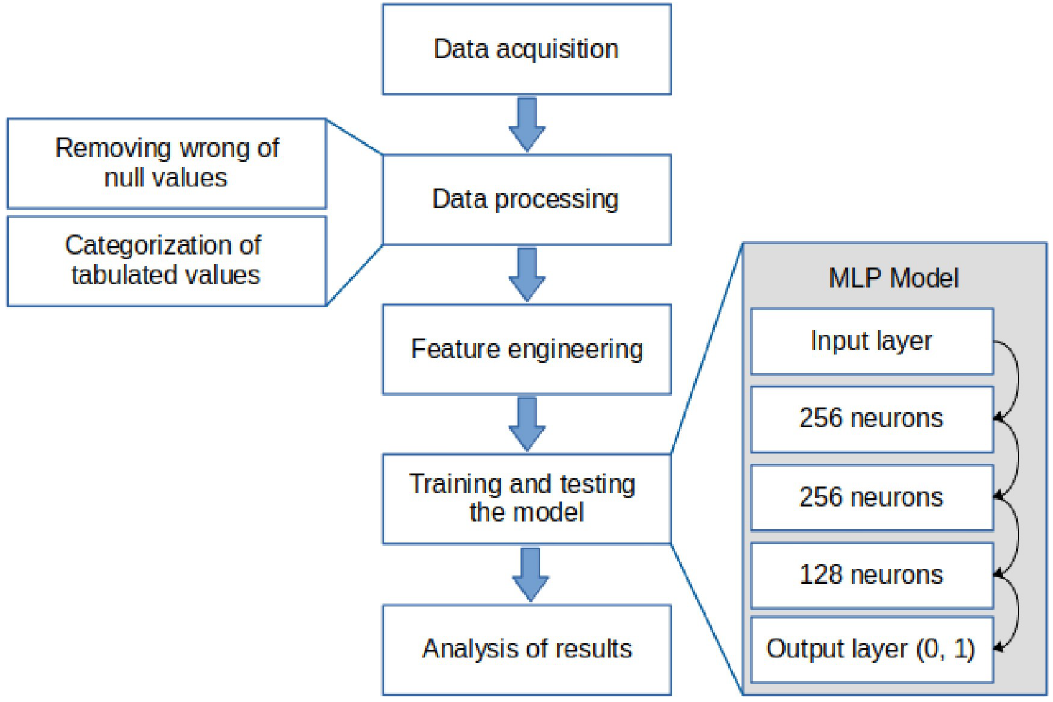
Fig 2. Task execution diagram from the data acquisition to the results of noncompaction cardiomyopathy patients.